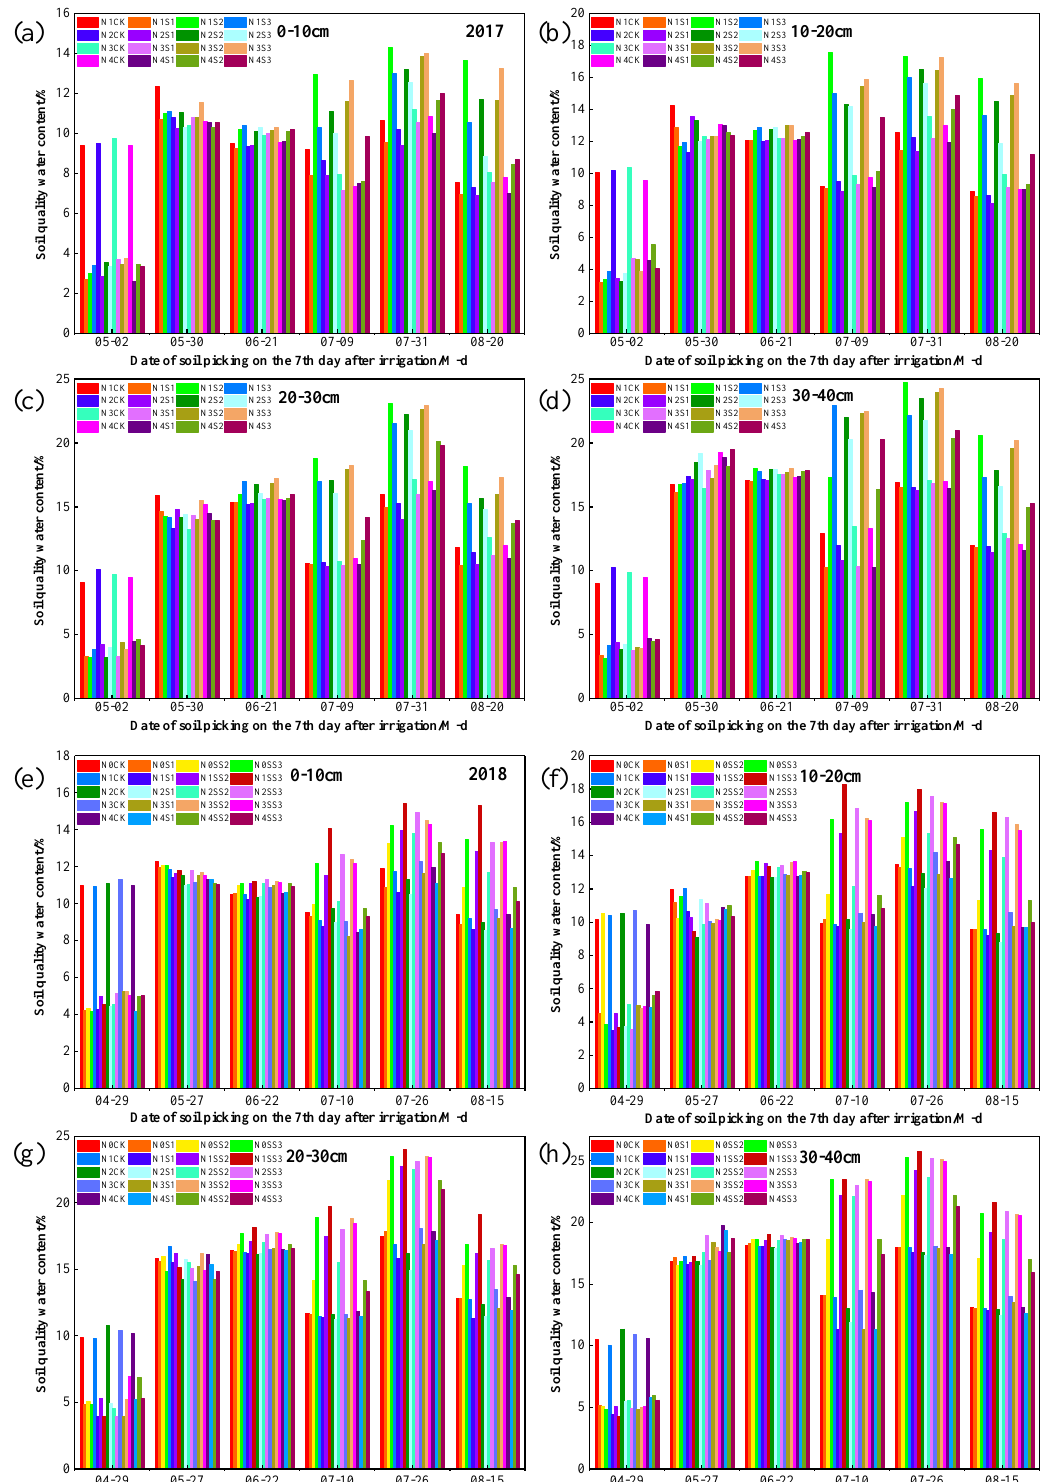
Figure 2. Distribution characteristics of soil moisture at different soil depths (0–10, 10–20, 20–30, and 30–40 cm) in 2017 ( a – d ) and 2018 ( e – h ).